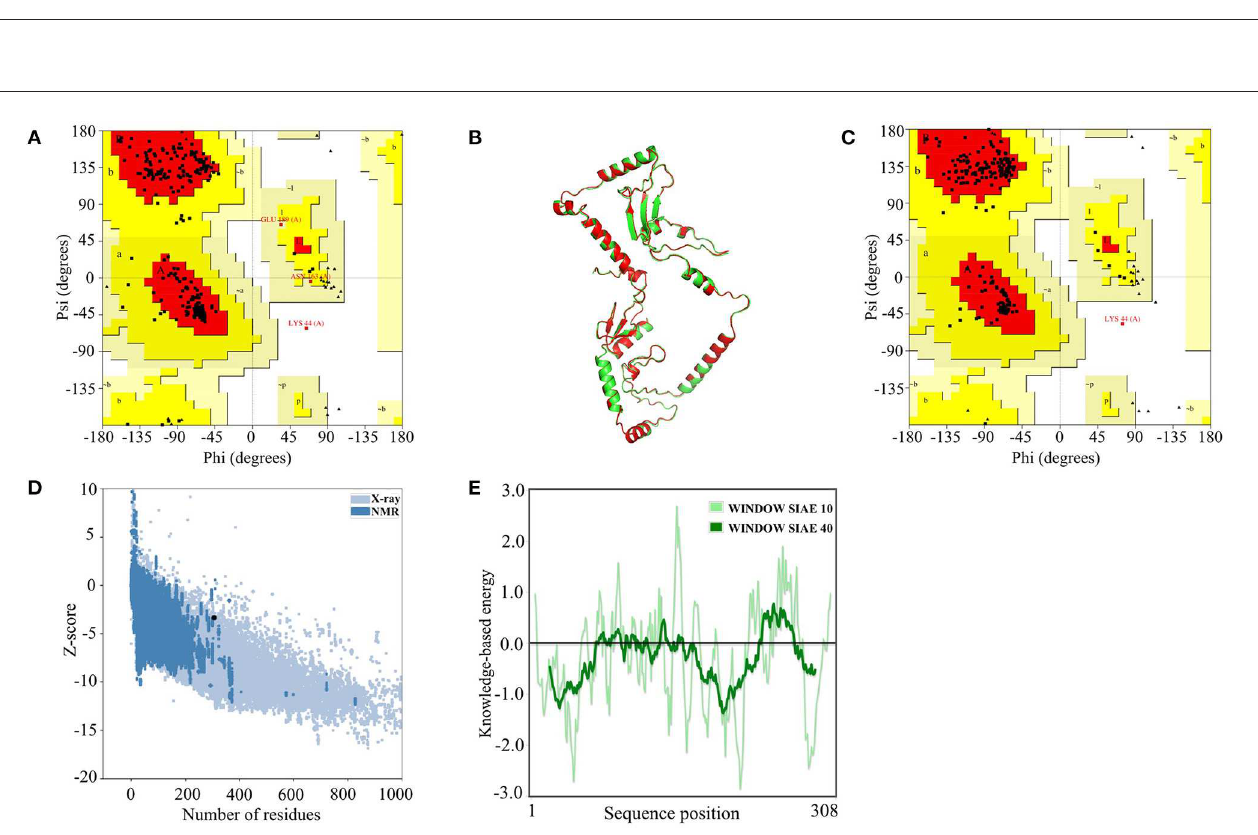
FIGURE6 Modeling of epitope vaccine tertiary structure. (A–E) Omega, Phi, Distance, Theta and Contact parameters of 2D structures; (F) Tertiary structure of candidate vaccine, Red: β -Defensin I molecular adjuvant; Yellow: CTL epitopes; Purple: Th epitopes; Green: B cell epitopes; TM-score: 0. 376.